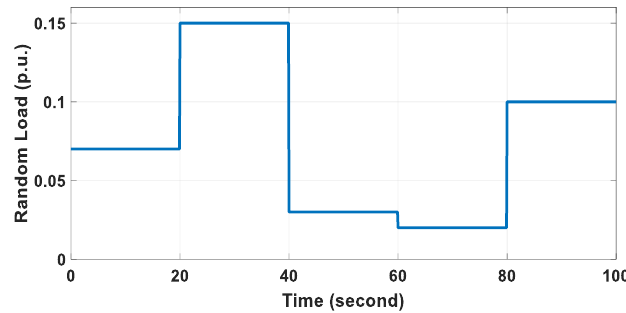
Figure 13. Profile of the random load.